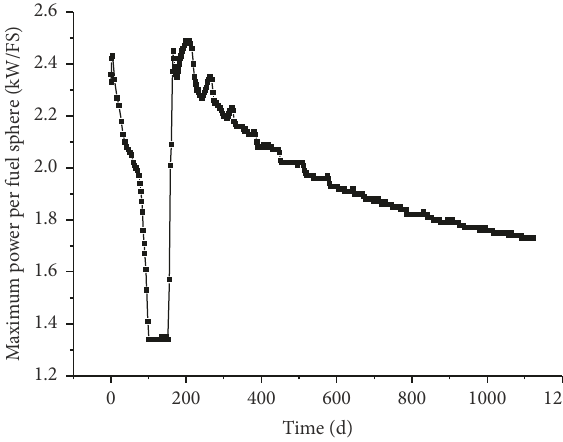
Figure 2: Maximum power per fuel sphere changing with